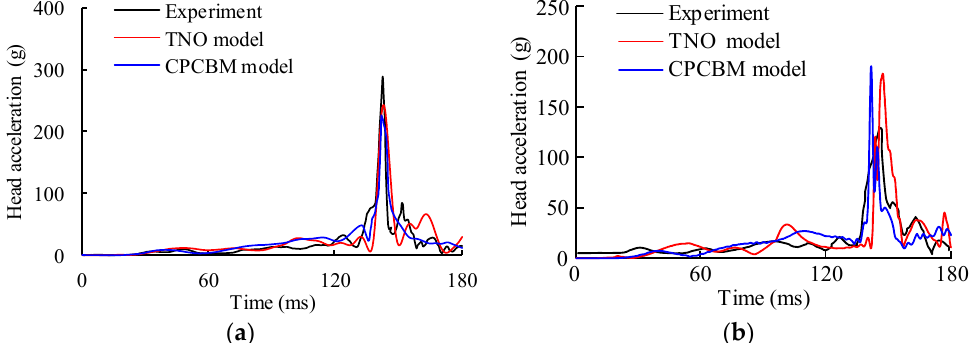
Figure A9. The resultant velocity of the head COG relative to the sedan buck: ( a ) test V2371; ( b ) test V2374.